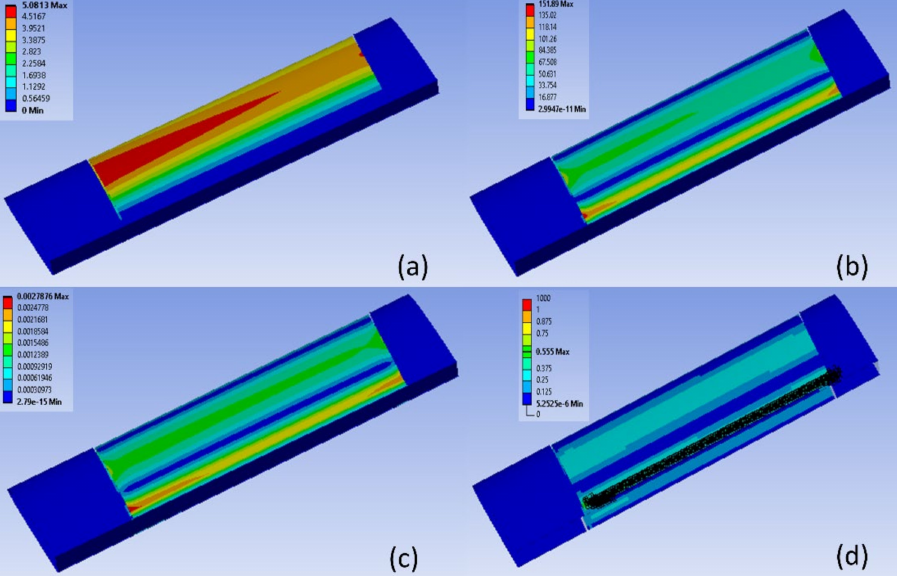
Figure 20. Leading Edge with glass fiber nose layup [0/90/ ± 45/90/0]: ( a ) deformation, ( b ) equiva- lent stress, ( c ) equivalent strain, ( d ) Inverse Reserve